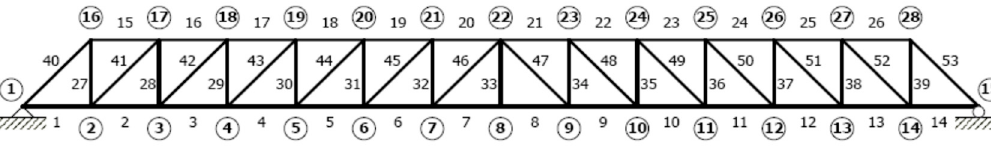
Figure 1. Schematic diagram of the plane hinged truss model. Table 1. Basic material parameters of the truss bridge.